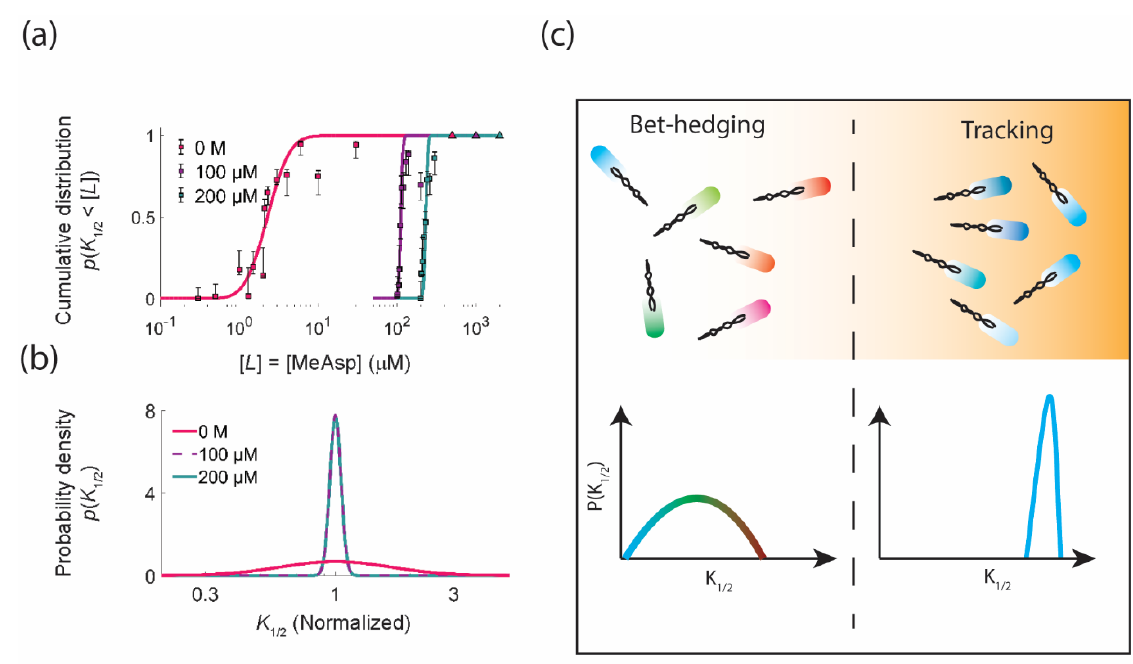
Figure 3. Bacteria tune the degree of sensory diversity in response to chemoattractant. ( a , b ) The cumulative distribution and probability density functions of the inverse sensitivity (K 1/2 defined as the stimulus level that elicits half-maximal response amplitude) for methyl-aspartate (MeAsp). When there is no chemoattractant in the environment, the sensitivity distribution is broad. However, when cells are exposed to non-zero chemoattractant concentrations, the sensitivity distribution sharply narrows. ( c ) The ability to modulate the degree of diversity in the sensitivity distribution according to the background stimulus could allow the population to switch between two navigational strategies in different environments. When no signals are present, cells have no information about future environmental signals, so they diversify their sensitivities for different ligands, improving the readiness for potential upcoming conditions (bet-hedging strategy). However, once a signal is detected, the population is benefited by having most cells being sensitive to the change in the signal level (tracking strategy). Panels a and b are adapted with permission from Kamino et al., 2020 [61].